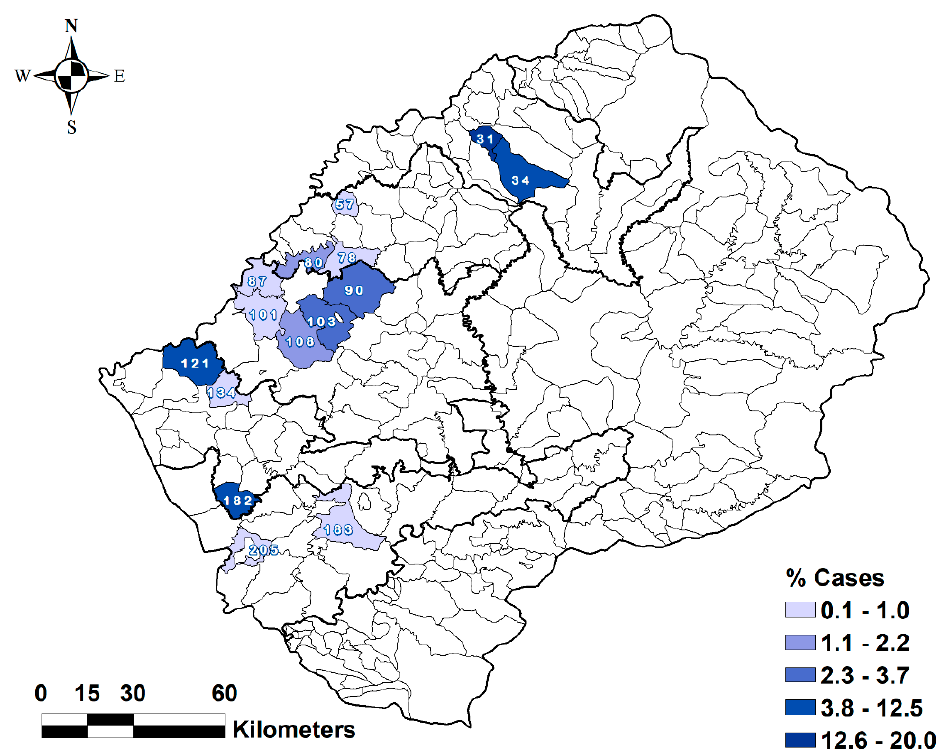
Figure 6. Distribution of anthrax cases over the population at risk in the Lowlands villages of Lesotho from 2005 to 2016.